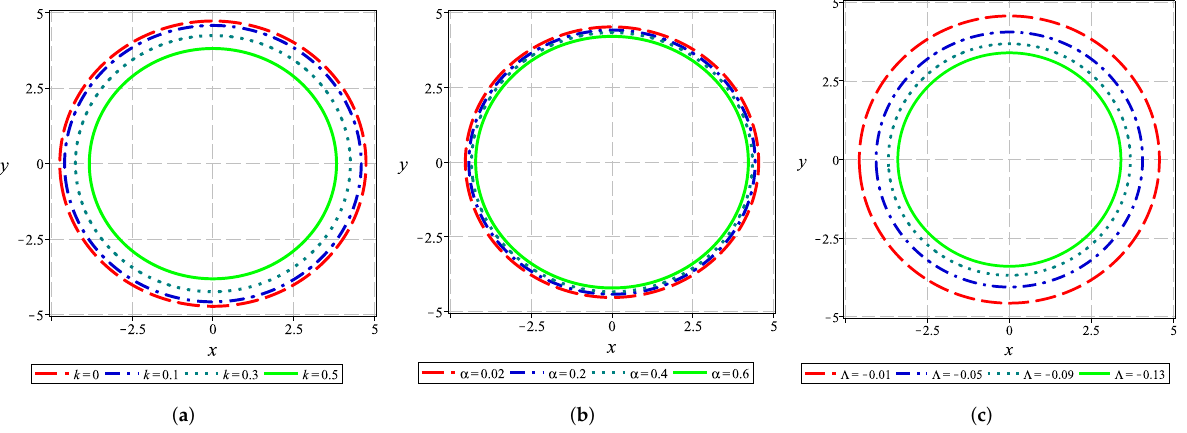
Figure 1. Black hole shadow in the Celestial plane ( x − y ) for M = 1. Note that increasing the NED ( k ) and GB ( α ) parameters, decreases the spherical shadow radius, as depicted in Figure 1a,b, respectively, whereas increasing the cosmological constant, increases the radius (Figure 1c). See the text for more details. ( a ) α = 0.2 and Λ = − 0.02; ( b ) k = 0.2 and Λ = − 0.02; ( c ) k = α =